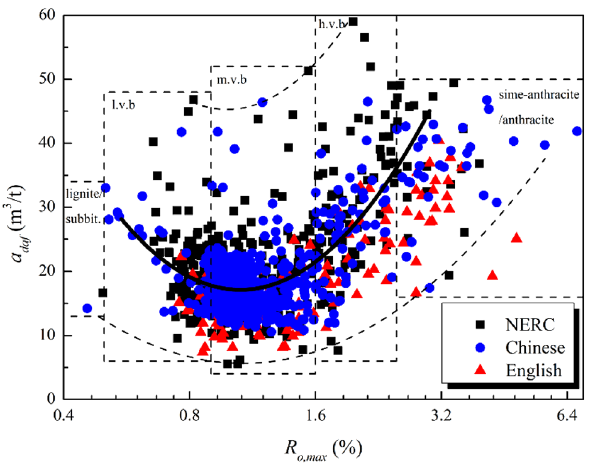
Fig. 2 Value of adsorption constant b versus vitrinite reflectance R o ; max . (Data size: NERC-290, Chinese (Zhang and Yang 1999; Su et al. 2006; Ma et al. 2008; Yang et al. 2009; Tian et al. 2010; Zheng 2012; Gao 2012; Ma et al. 2014; Pan and Xu 2015; Xu and Pan 2015)- 217, English (Joubert et al. 1973; Yalc¸in and Durucan 1991; DeGance et al. 1993; Chaback et al. 1996; Bustin and Clarkson 1998; Nodzen´ski 1998; Faiz et al. 2007a, b; Yu et al. 2008a, b,